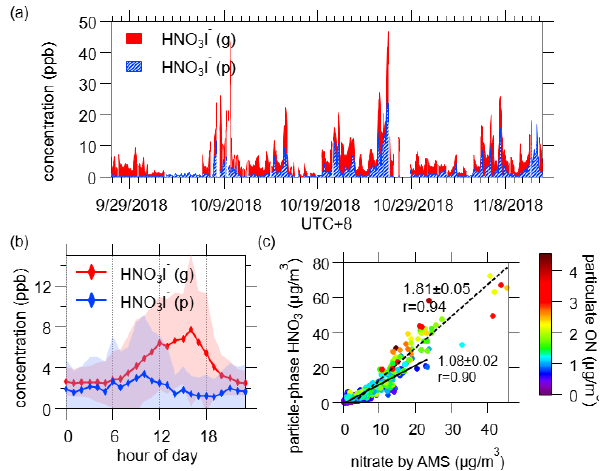
Figure 11. (a) Time series of humidity-corrected HNO 3 I − in both phases. (b) Diurnal variation of humidity-corrected HNO 3 I − . The shaded areas indicate 1 standard deviation. (c) Comparison of particle-phase HNO 3 I − and nitrate measured by AMS. The color scale denotes particulate N-containing organic compounds mea- sured by FIGAERO-I-CIMS (pON). The solid and dash lines show the fitted results for the dataset of pON less than 1µg/m 3 and more than 1µg/m 3 , respectively. The concentration of gaseous HNO 3 I − shown here only included the last 5min of every gas-phase work- ing mode, as high level of HNO 3 came out of aerosol, which then passed through the CIMS in a short time during particle analysis, and a substantial amount would subsequently accumulate on the inner surfaces, leading to a persistent carried over signal that was long enough to disturb the next gas measurement cycle (Palm et al., 2019).